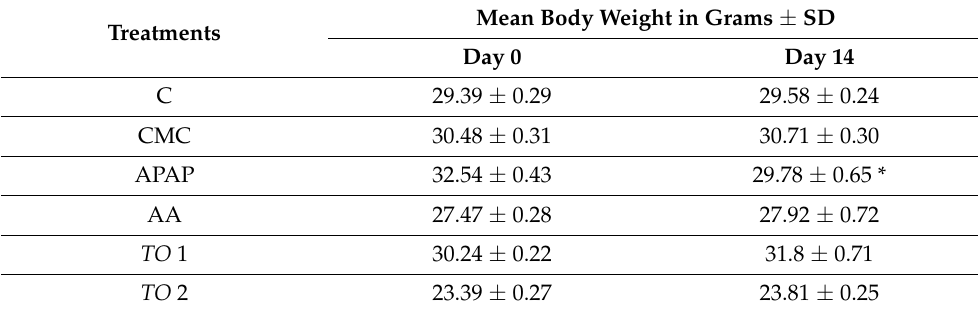
Table 4. Body weight of mice during the treatment period.